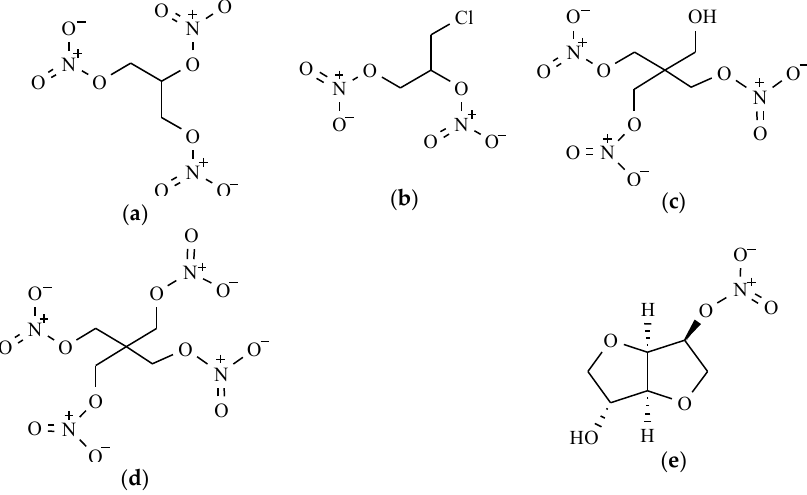
Figure 1. The chemical structure of some organic nitrates: ( a ) Nitroglicerinum; ( b ) Clonitrate; ( c ) Pentrinitrol; ( d ) Nitropentaerythritol; and ( e ) 5-Isosorbide mononitrate. Organic Nitrates’ Mechanism of Action